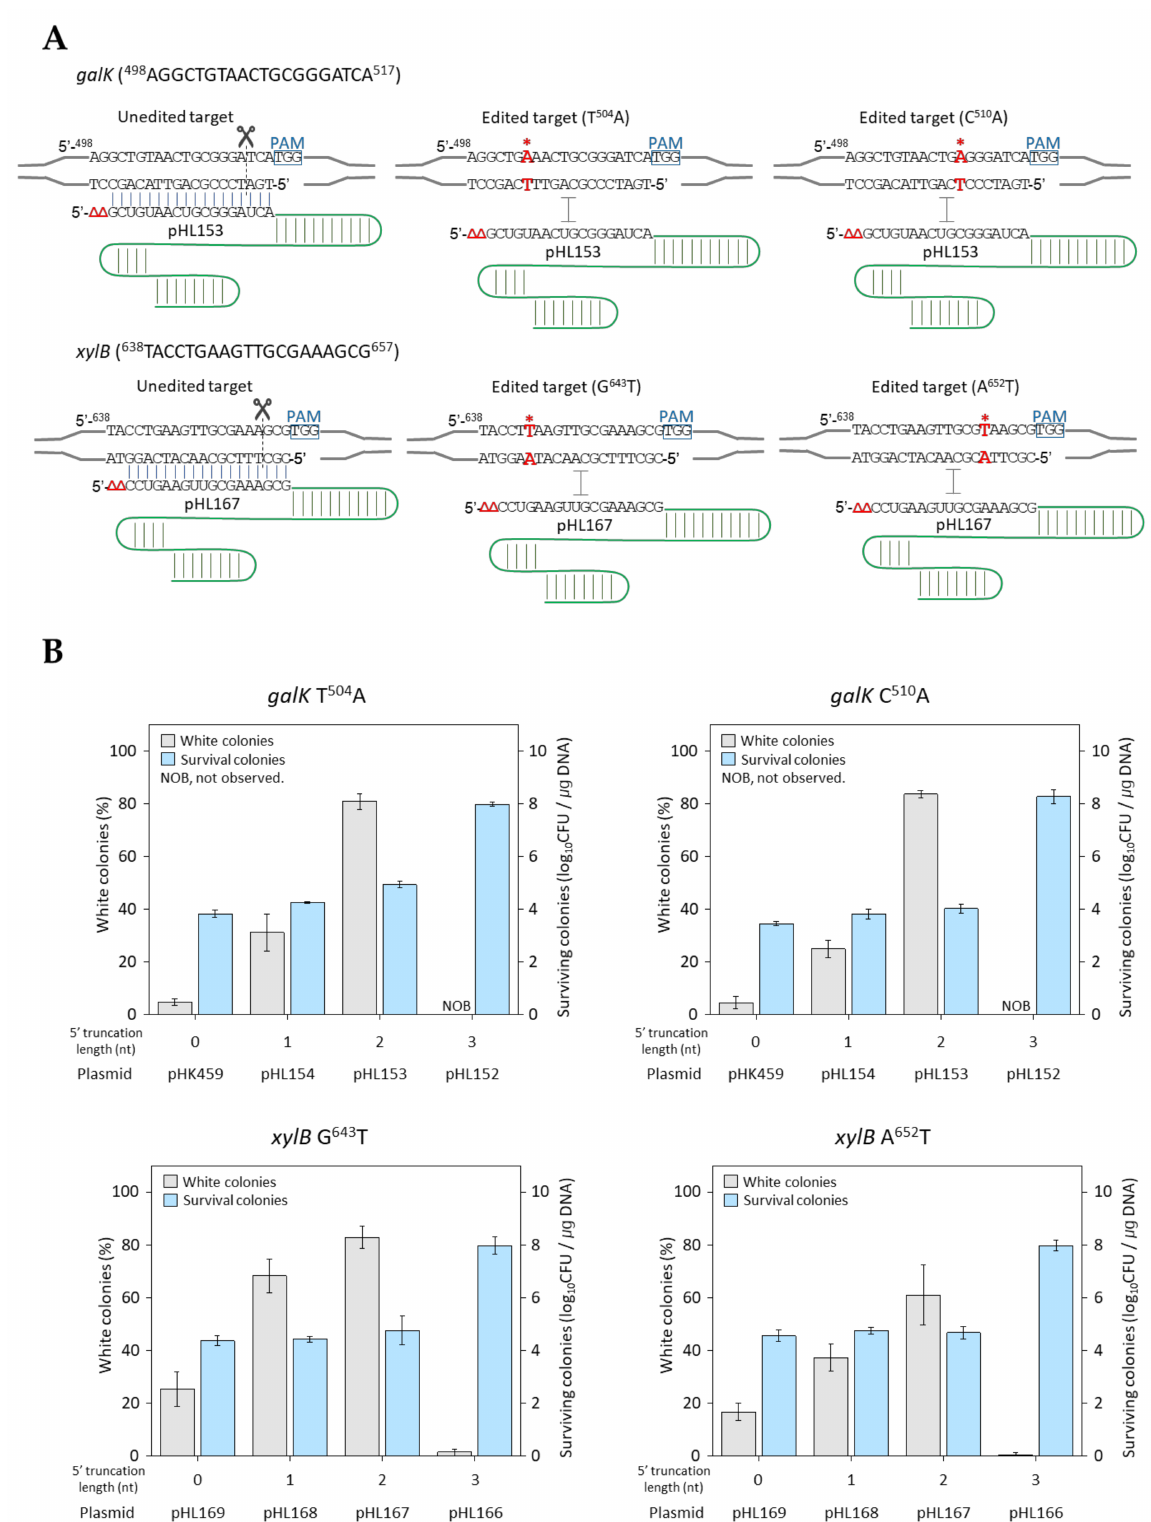
Figure 2. Efficiency of single-base editing by truncated sgRNA/Cas9-mediated negative selection. ( A ) Target sequences and design of truncated sgRNAs for the negative selection of edited targets in galK and xylB . Asterisk represent single point mutations. ( B ) Efficiency of single-base editing in galK and xylB target using 5 (cid:48) -untruncated, 1 nucleotide-, 2 nucleotide-, and 3 nucleotide-truncated sgRNAs. Each bar represents the standard deviation of three independent